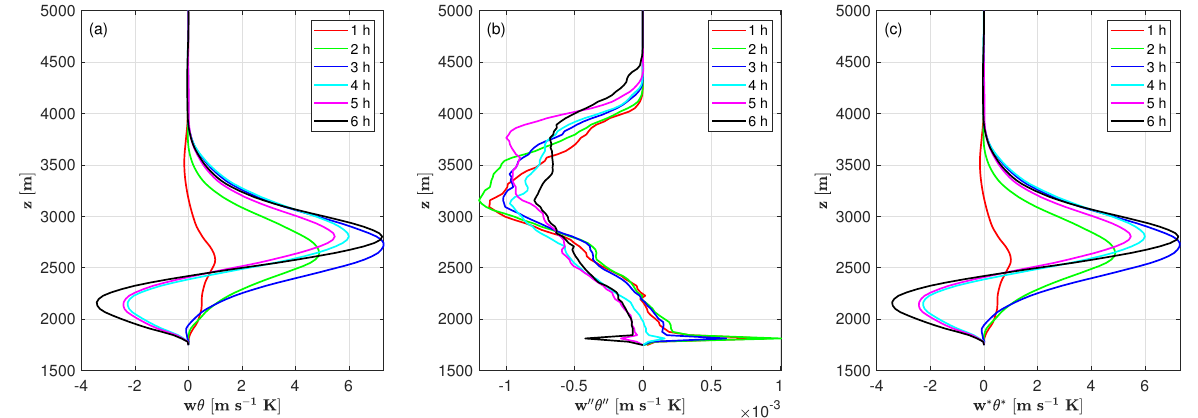
Figure 8. Horizontal mean vertical profiles of ( a ) total heat flux, ( b ) sub-grid scale (SGS) heat flux and ( c ) resolved-scale heat flux at the whole domain in time after the start of the simulation at 06:00 UTC. Figure 9 shows the vertical profiles of horizontally averaged flux components wu , wv and subgrid-scale turbulent kinematic flow e over the whole domain at UTC 07:00, UTC 09:00 and UTC 12:00. Following about one-hour spinup time, the differences in fluxes between the two SGS models are determined to be insignificant, while SGS turbulent kinematic energy values calculated using the Deardorff SGS model are clearly higher than those calculated using the dynamic SGS model, in particular near the wall. This impact can be described as the Deardorff model not being capable of resolving as many small eddies near the wall as the dynamical SGS model, when same grid spacing is used. The vertical profiles of variances horizontally averaged over the whole domain are plotted in Figure 10. During the time revolution, the maximal values remain at the same altitude. Similarly, there are no significant differences between the two models in computing velocity variance, once the simulation is stabilized.